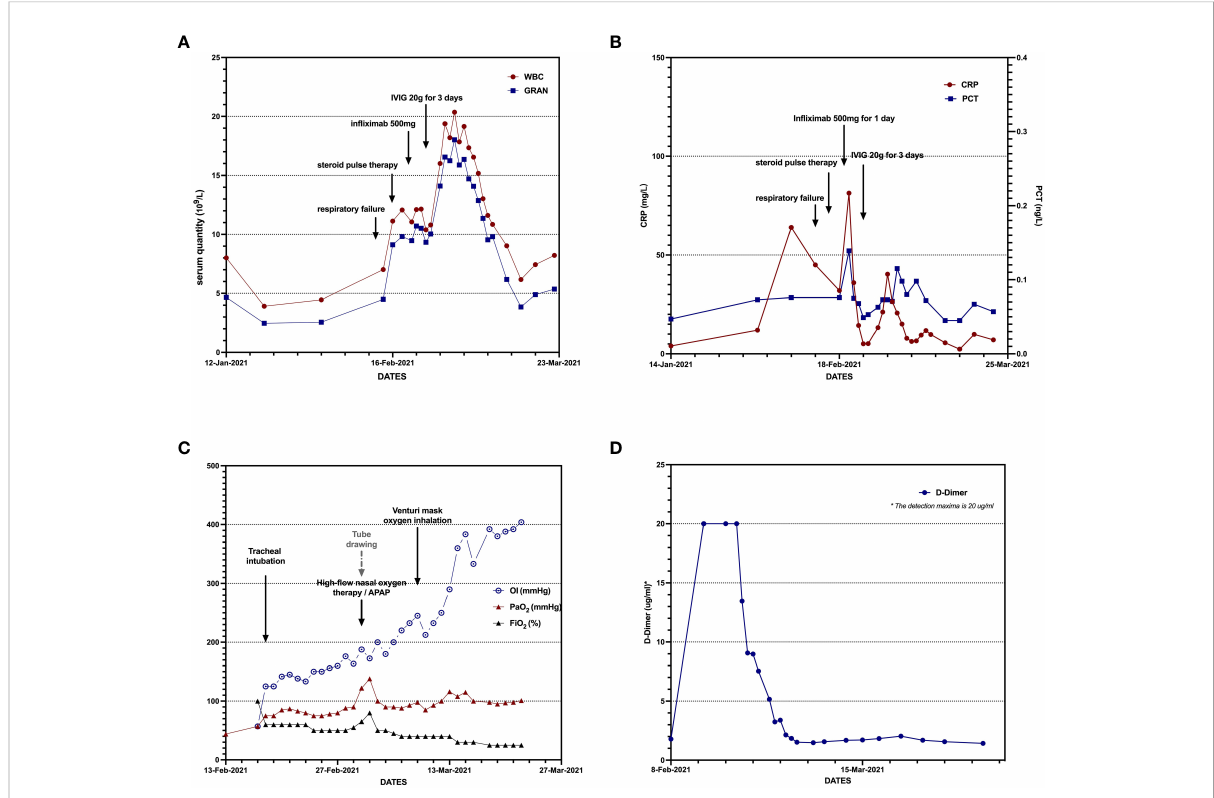
FIGURE 3 Dynamic changes in laboratory examination: in fl ammatory reaction, hypoxia with hypercoagulable state (A – D) .